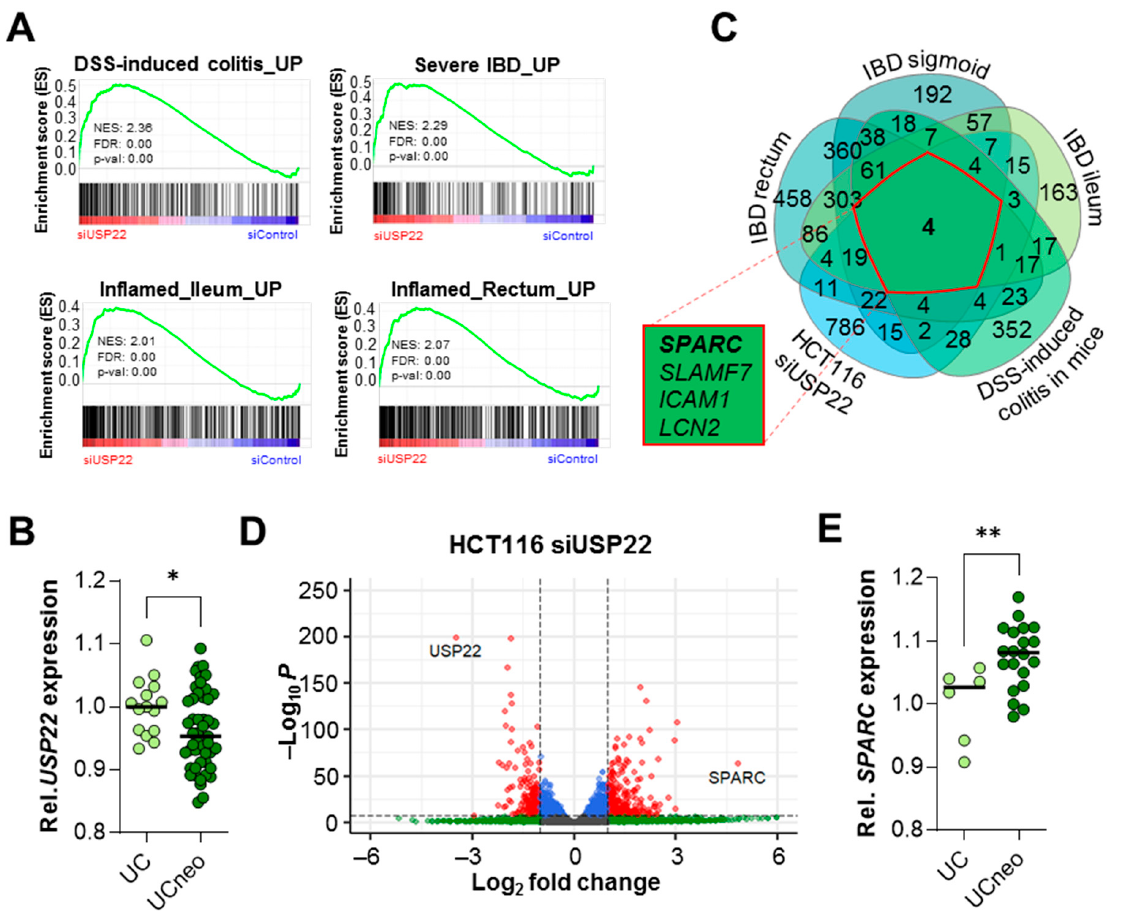
Figure 5. The loss of Usp22 drives inflammatory bowel disease (IBD)-associated transcriptome-wide changes and promotes SPARC expression. ( A ) Gene set enrichment analysis of mRNA-seq data from USP22-depleted HCT116 cells showing enrichment of gene expression signatures upregulated in mice experiencing acute DSS-induced colitis [20] and in IBD patients [21,22]. ( B ) Compared to patients with ulcerative colitis (UC), individuals with UC-associated neoplasm (UCneo) displayed lower USP22 expression, as demonstrated using microarray analysis [26]. ( C ) Genes upregulated in USP22- depleted HCT116 cells were compared to genes upregulated in IBD patients [21] and mice experiencing colitis [20]. All five gene sets displayed elevated expression of SPARC . ( D ) Volcano plot displaying profound SPARC upregulation following USP22 depletion in HCT116 cells, as detected using mRNA-seq. ( E ) Patients with UC-associated neoplasm and reduced USP22 expression showed elevated SPARC mRNA levels compared to UC patients [26]. Mean ± SEM. Student’s t -test. * p ≤ 0.05, ** p ≤ 0.01.